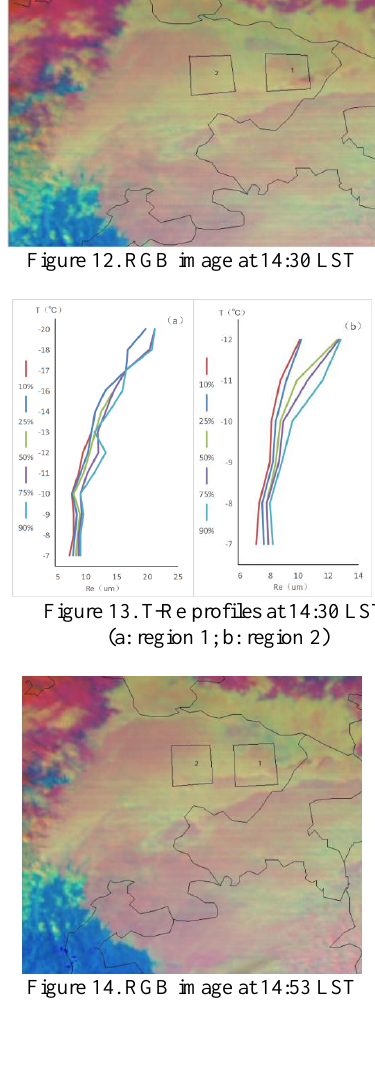
Figure 14. RGB image at 14:53